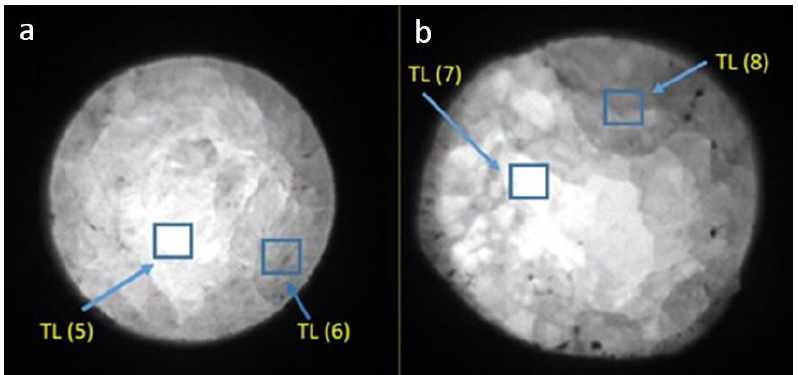
Figure 9. Images of the luminous surface of samples No. 7 ( a ) and No. 17 ( b ) cut out from the LMP crystal doped with 1.2-mol% Tm and 10-mol% B. The images were recorded in a reader with a CCD camera after irradiation with 20 Gy of beta rays. Marked boxes correspond to the sites of TL signal measurement.